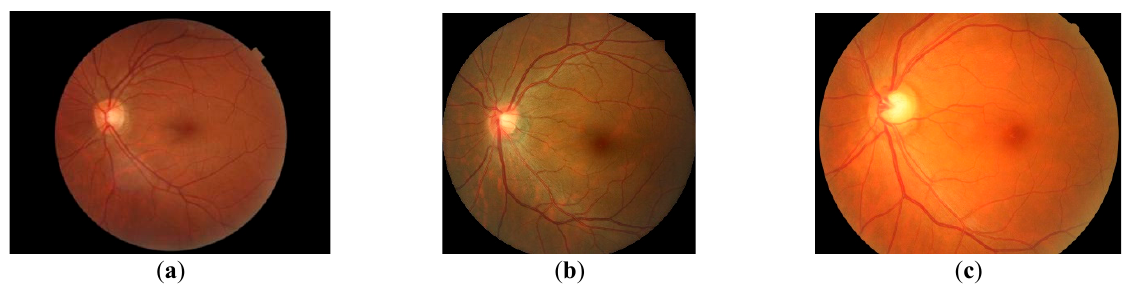
Figure 5. ROI of fundus image. ( a – c ) are examples of ROI regions that are smaller, roughly the same size as, and larger than the fundus image, respectively.